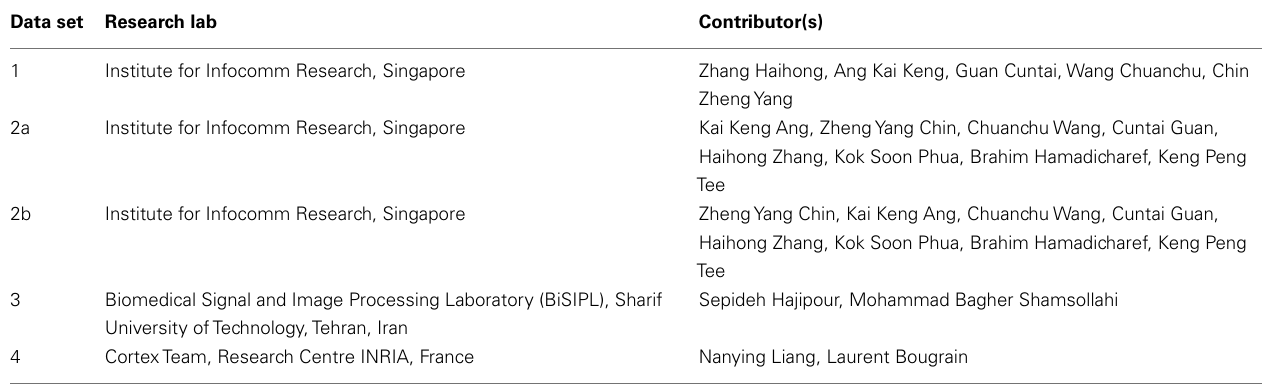
Table 2 |ThisTable lists the winning teams for all competition data